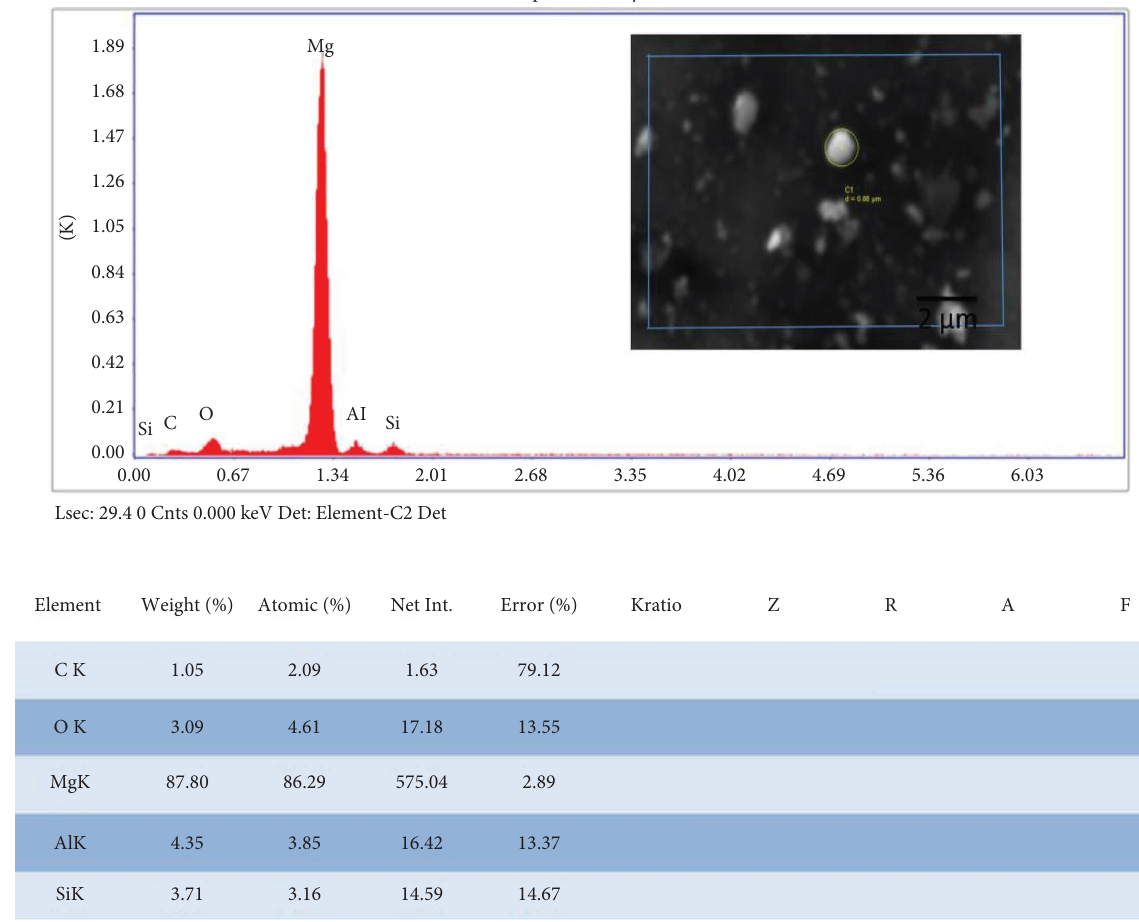
Figure 5: EDS analysis of AZ31/SiC/Gr nanocomposites.